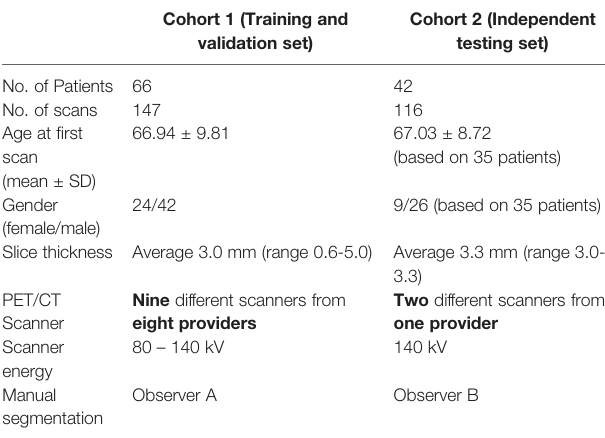
TABLE 1 | Patient and scanner